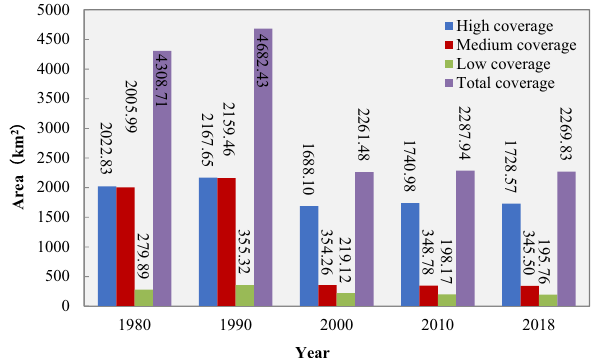
Figure 2. Changes of grassland area with different coverage